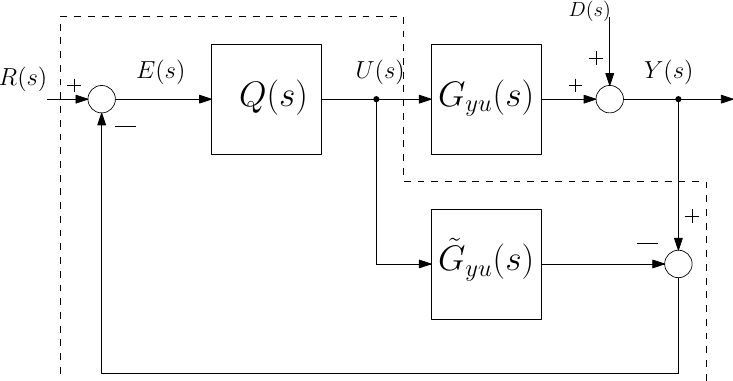
Figure 9. IMC feedback control setup ( Q ( s ) IMC